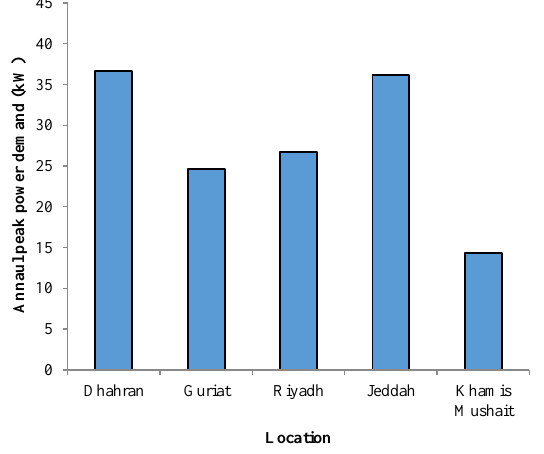
Figure 11. Annual peak power demand for the base house based on the optimum orientation in the five climatic zones.